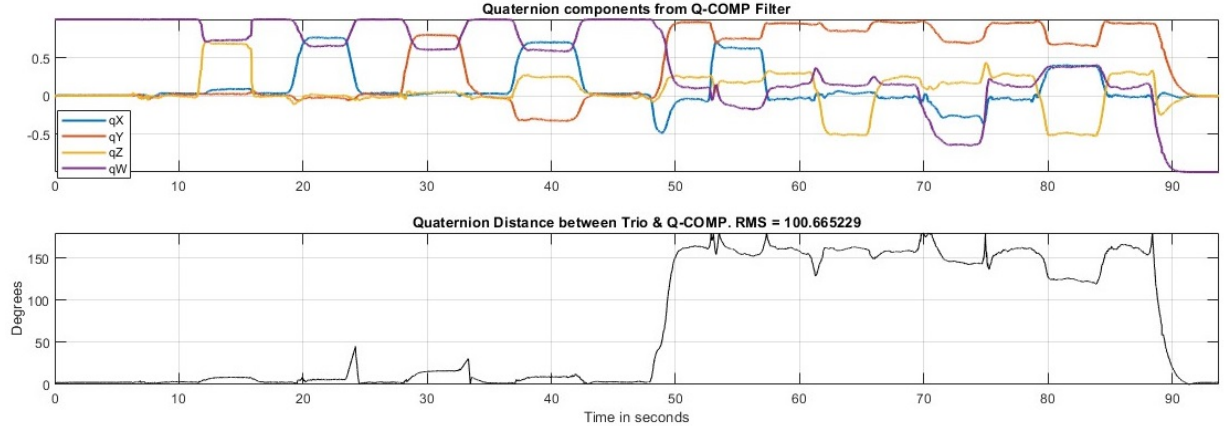
Figure A1. ( Top ) evolution of the quaternion components generated by the Q-COMP onboard filter. ( Bottom ) evolution of the quaternion distance between the Trio quaternion result and the Q-COMP quaternion result.